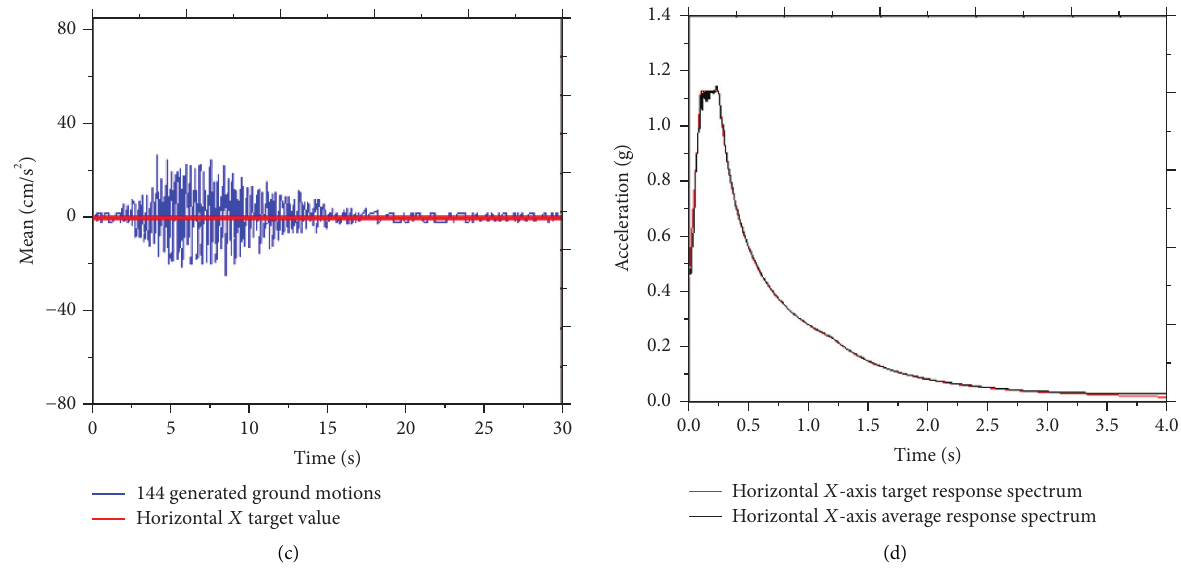
Figure 6: Comparison of the horizontal X component of the sample with the target value. (a) Representative time history, (b) mean, (c) standard deviation, and (d) average response